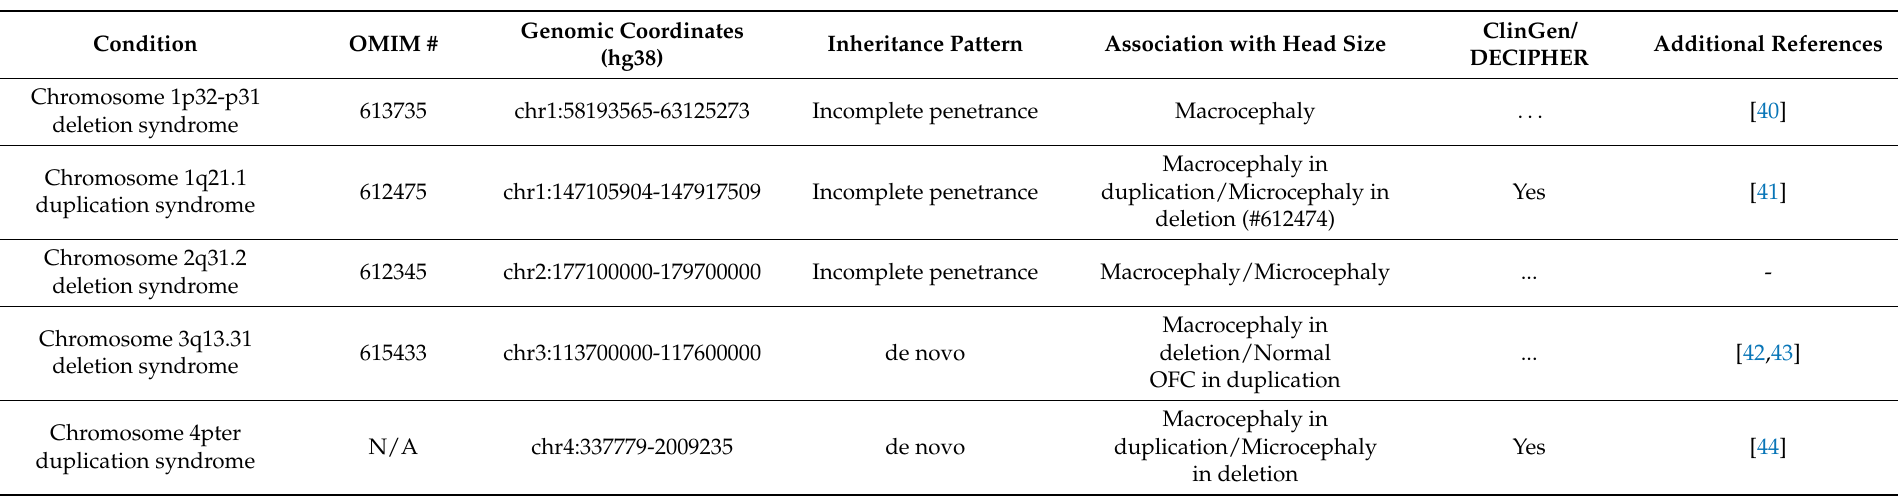
Table 3. Twenty-eight recognized loci harboring deletion/duplication syndromes associated with macrocephaly (OMIM number, genomic coordinates, inheritance pattern, and ClinGen/DECIPHER data are shown, when